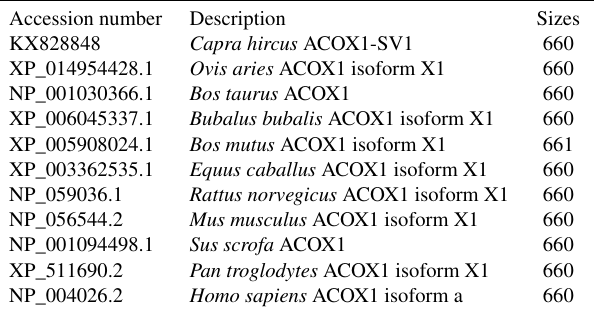
Table 2. Accession numbers and description of the amino acid se- quences used in tree